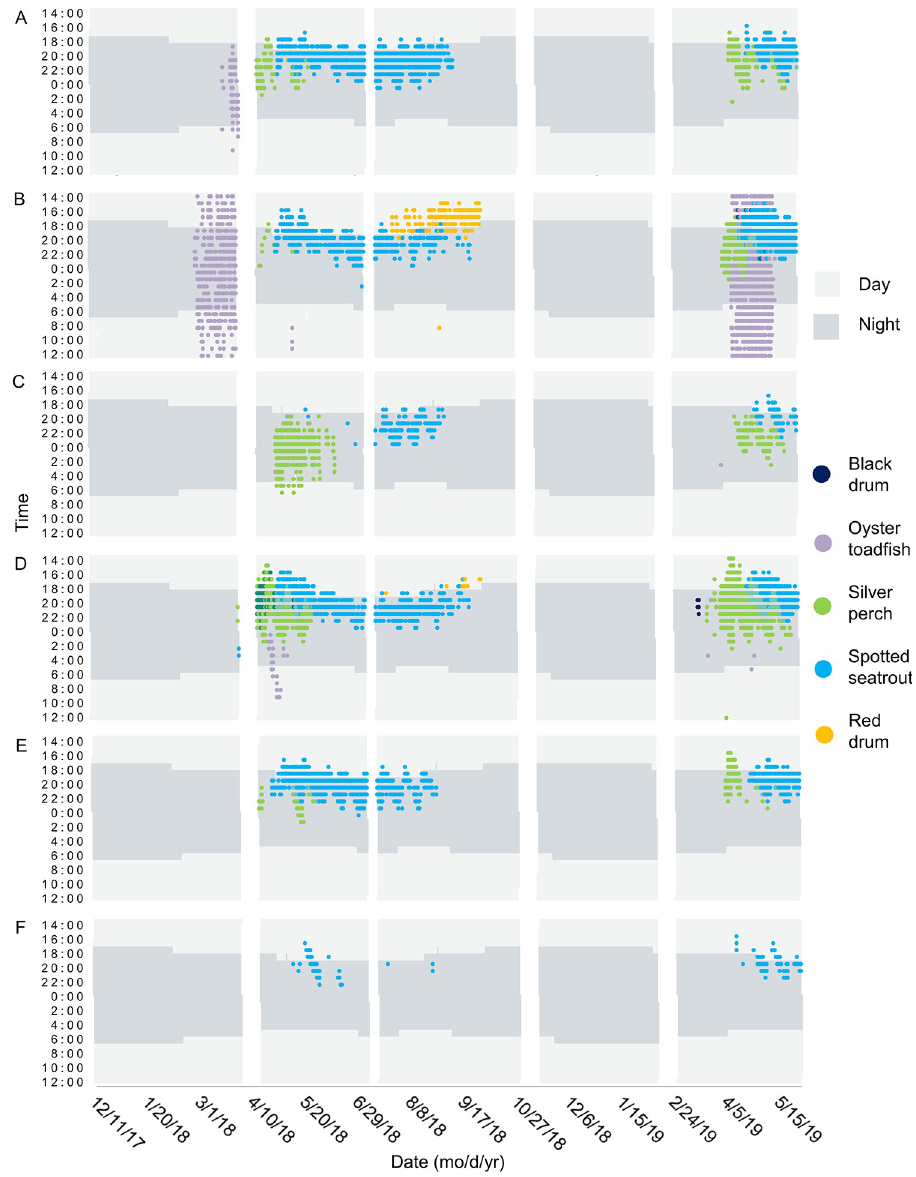
Fig 8. Heat map of fish chorusing with day/night background. Spatial and temporal patterns of fish chorusing in Charleston Harbor. Time is shown between noon and noon the next day at (A) Wando River, (B) Drum Island, (C) SC Aquarium, (D) Fort Sumter, (E) Ashley River, and (F) Citadel stations. Background color represents whether the time is during the day or night. White spaces represent gaps in the data due to maintenance of equipment between deployments. Blended colors indicate an overlap in species